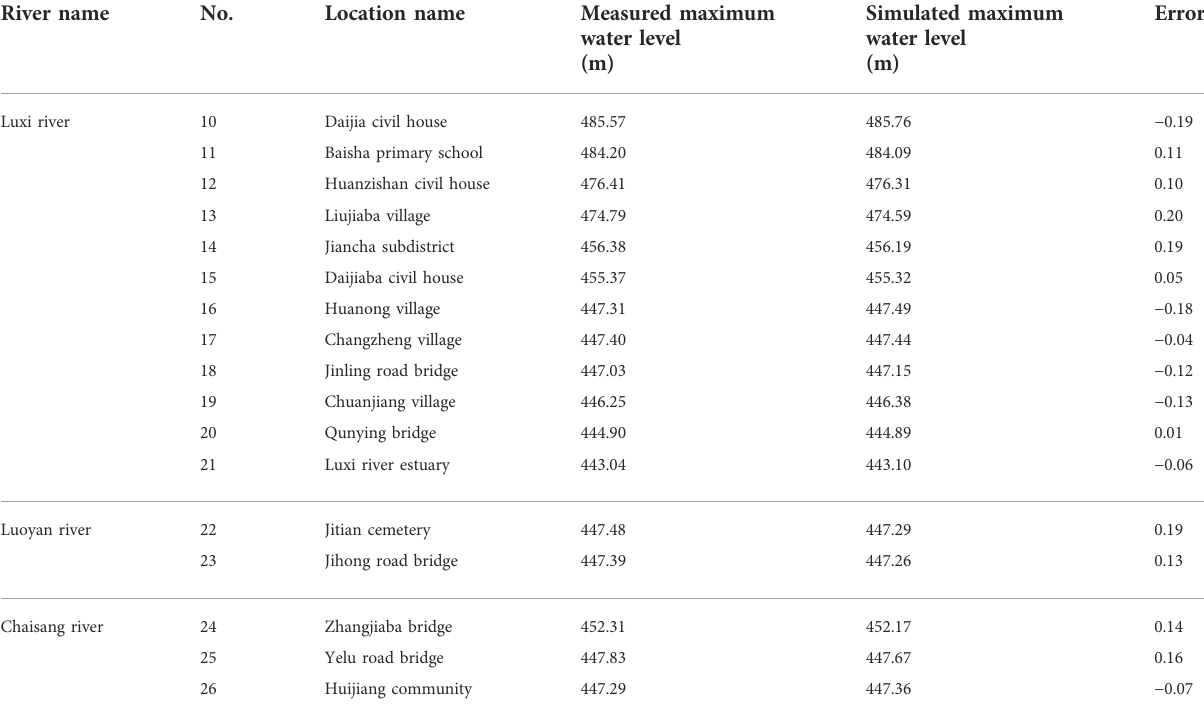
TABLE 3 Partial comparison of simulated and measured water level at fl ood mark points of Luxi river basin. River